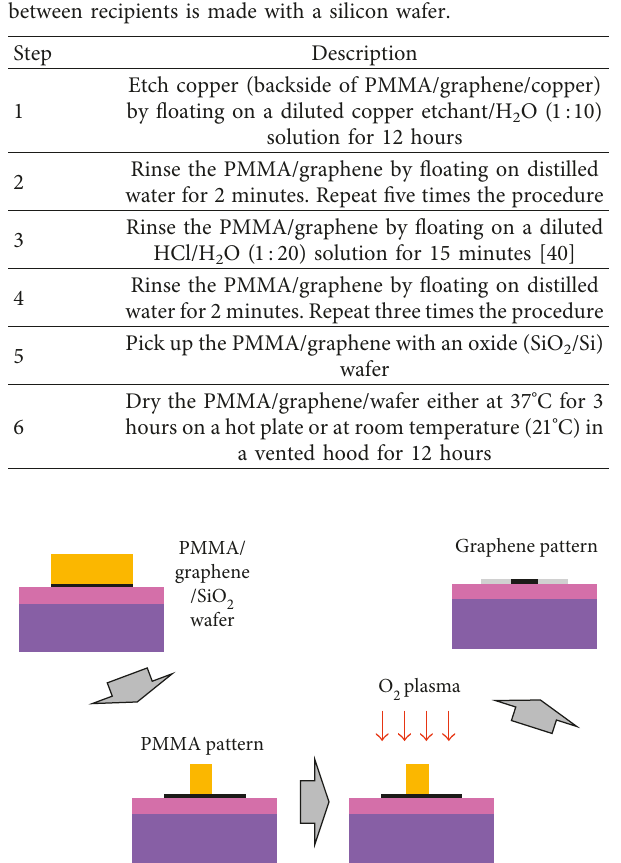
Figure 2: Patterning of graphene using a protective mask (PMMA) and exposure to oxygen plasma. Normally, PMMA shows poor resistance to oxygen plasma. The present work proposes novel physical processing parameters to enable the usage of PMMA as a mask to create ribbon patterns on graphene. Electron-beam (e-beam) lithography is used to create the PMMA